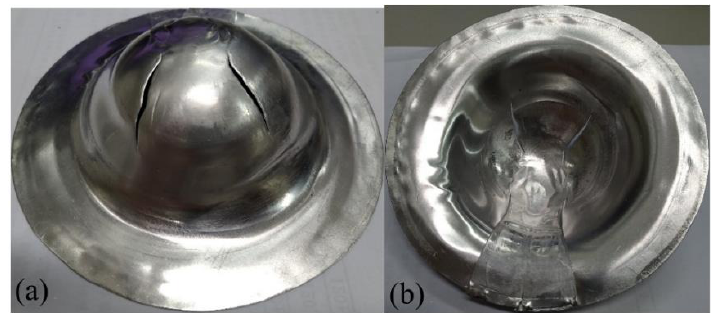
Figure 11. Deep drawing of Al 6061-composite sandwich with 190 °C preheating: ( a ) front view, ( b ) back view.